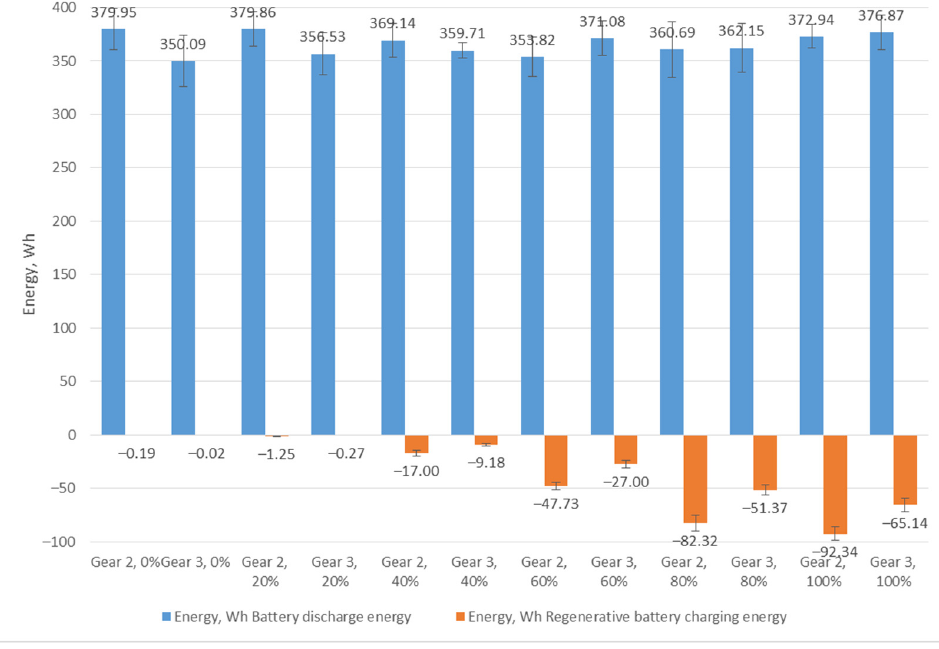
Figure 7. Battery discharge and regenerative braking charging energy during the driving